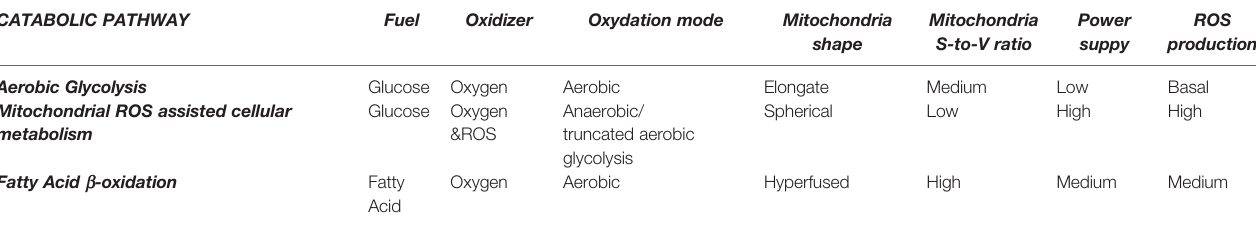
TABLE 1 | The three different mitochondria operating modes. CATABOLIC